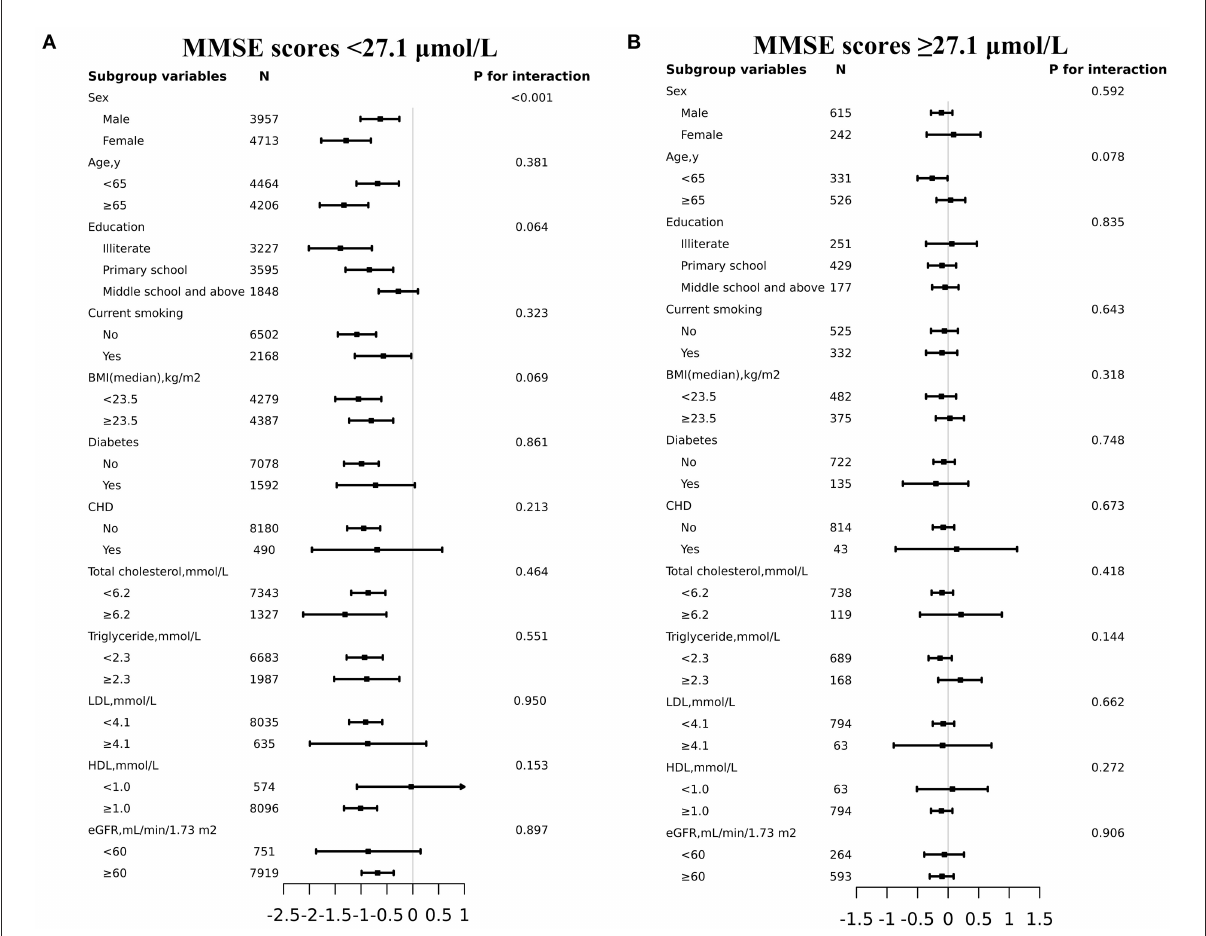
FIGURE3 Effect size of plasma tHcy levels on MMSE scores in prespecified and exploratory subgroups. ( A : plasma tHcy levels < 27.1 µ mol/L, B : plasma tHcy levels ≥ 27.1 µ mol/L). Each subgroup analysis adjusted for age, sex, education, BMI, smoking status, diabetes, CHD, antihypertensive drugs, SBP, DBP, total cholesterol, triglycerides, HDL-C, LDL-C and eGFR except for the stratifying